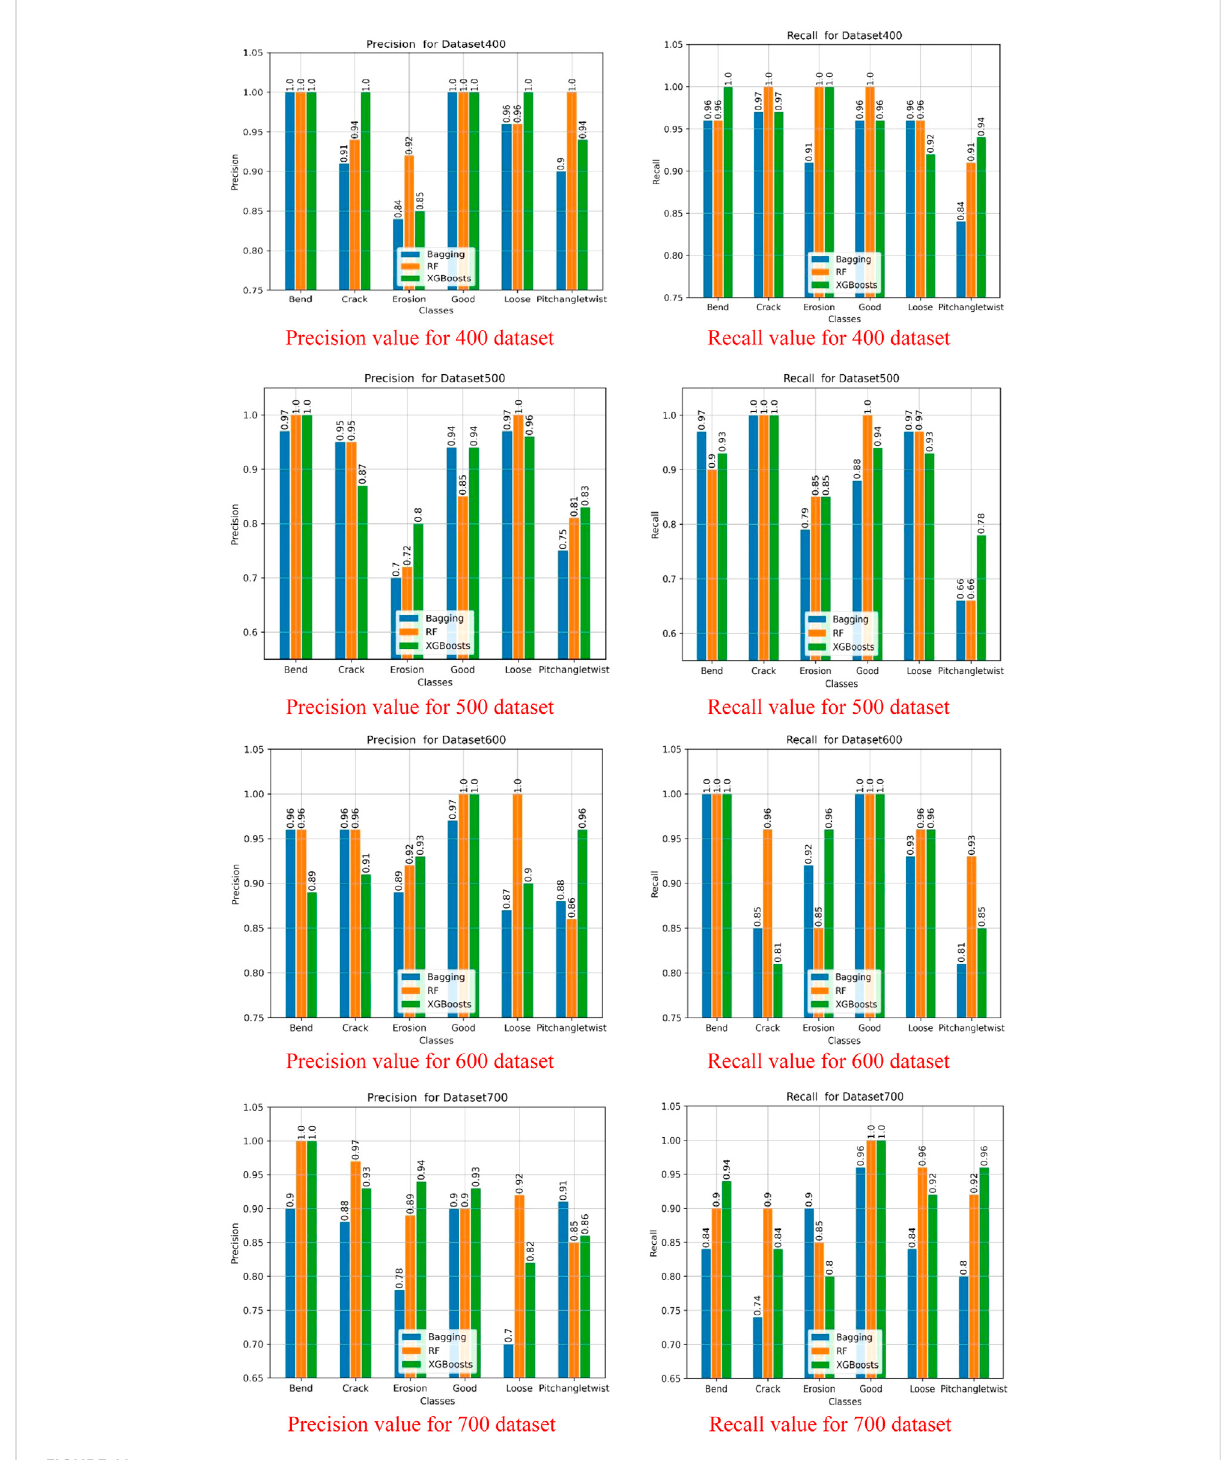
FIGURE 11 Precision and recall values for the 400, 500, 600, and 700